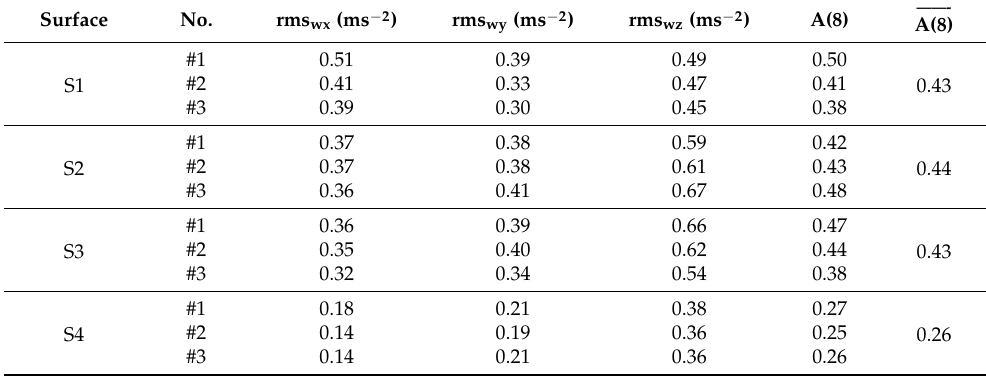
Table 4. Summary of data obtained from driver 1 according to ISO 2631-1:1997, method A(8). Surface